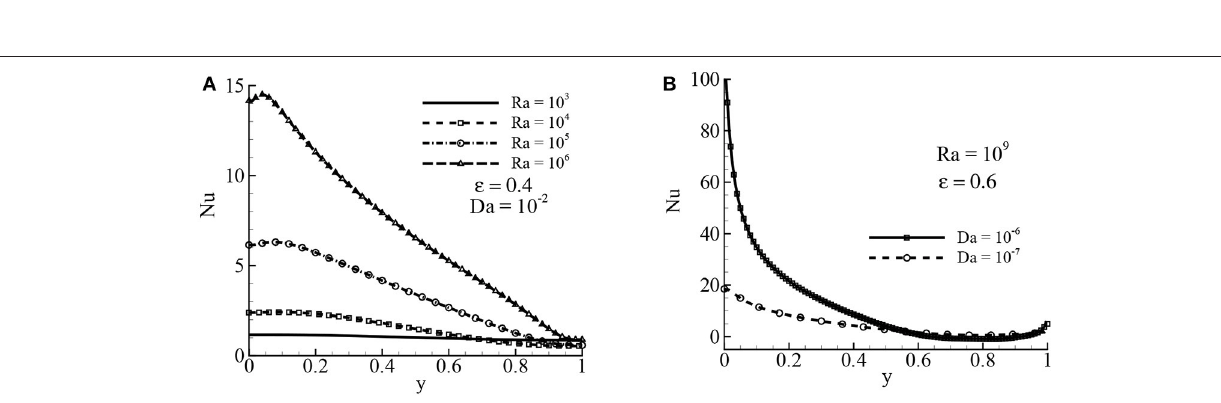
1.0, Da 10 − 2 , and ǫ 0.4. = = =